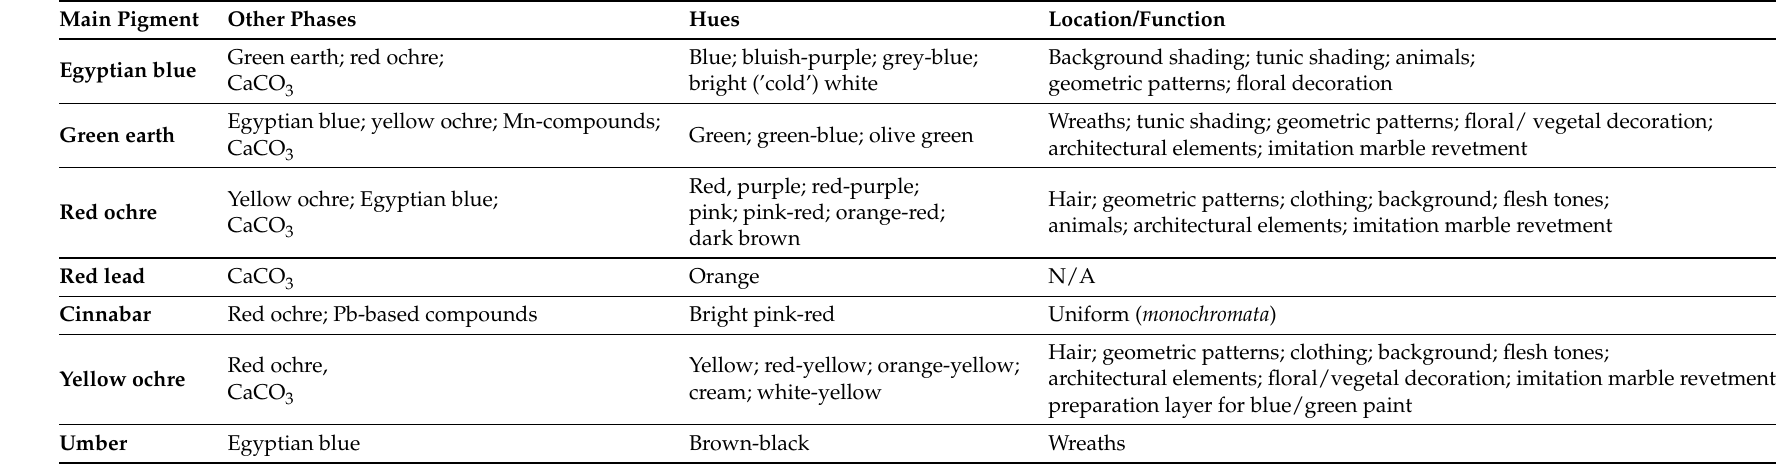
Table 3. The hues, application methodology, and function of pigments identified in the ancient Cypriot wall paintings. The main hues listed here were found in shades of light to dark